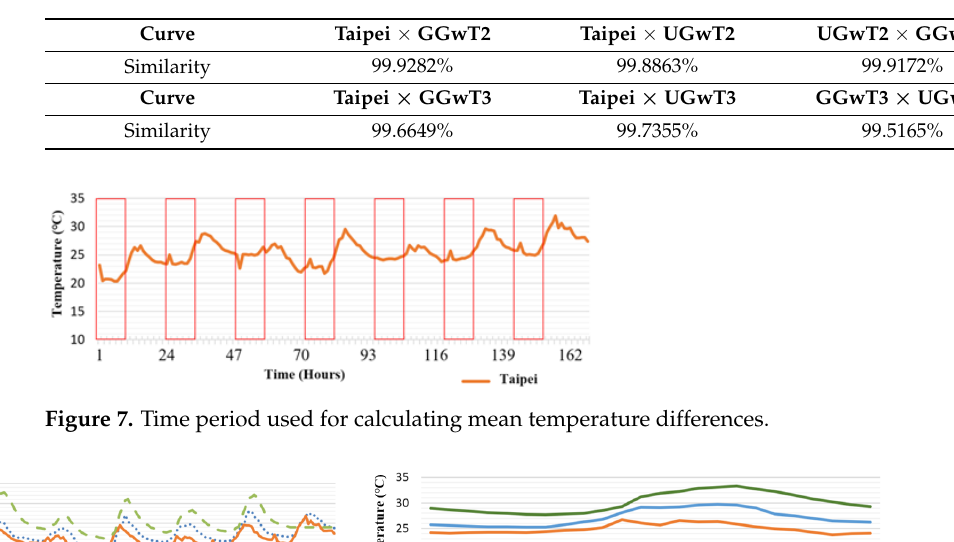
Table 10. Regions C and D: Similarities between permeable brick pavements.